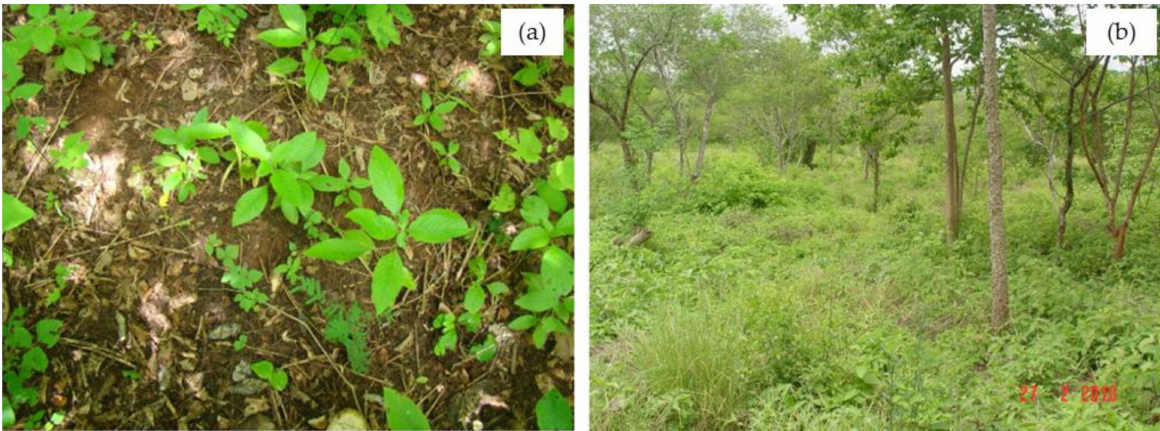
Figure 3. Groundcover: ( a ) R-SDTF and ( b ) T-SDTF. Photos by the